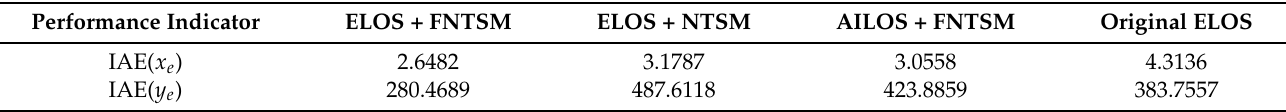
Table 3. Performance indicator of path-following